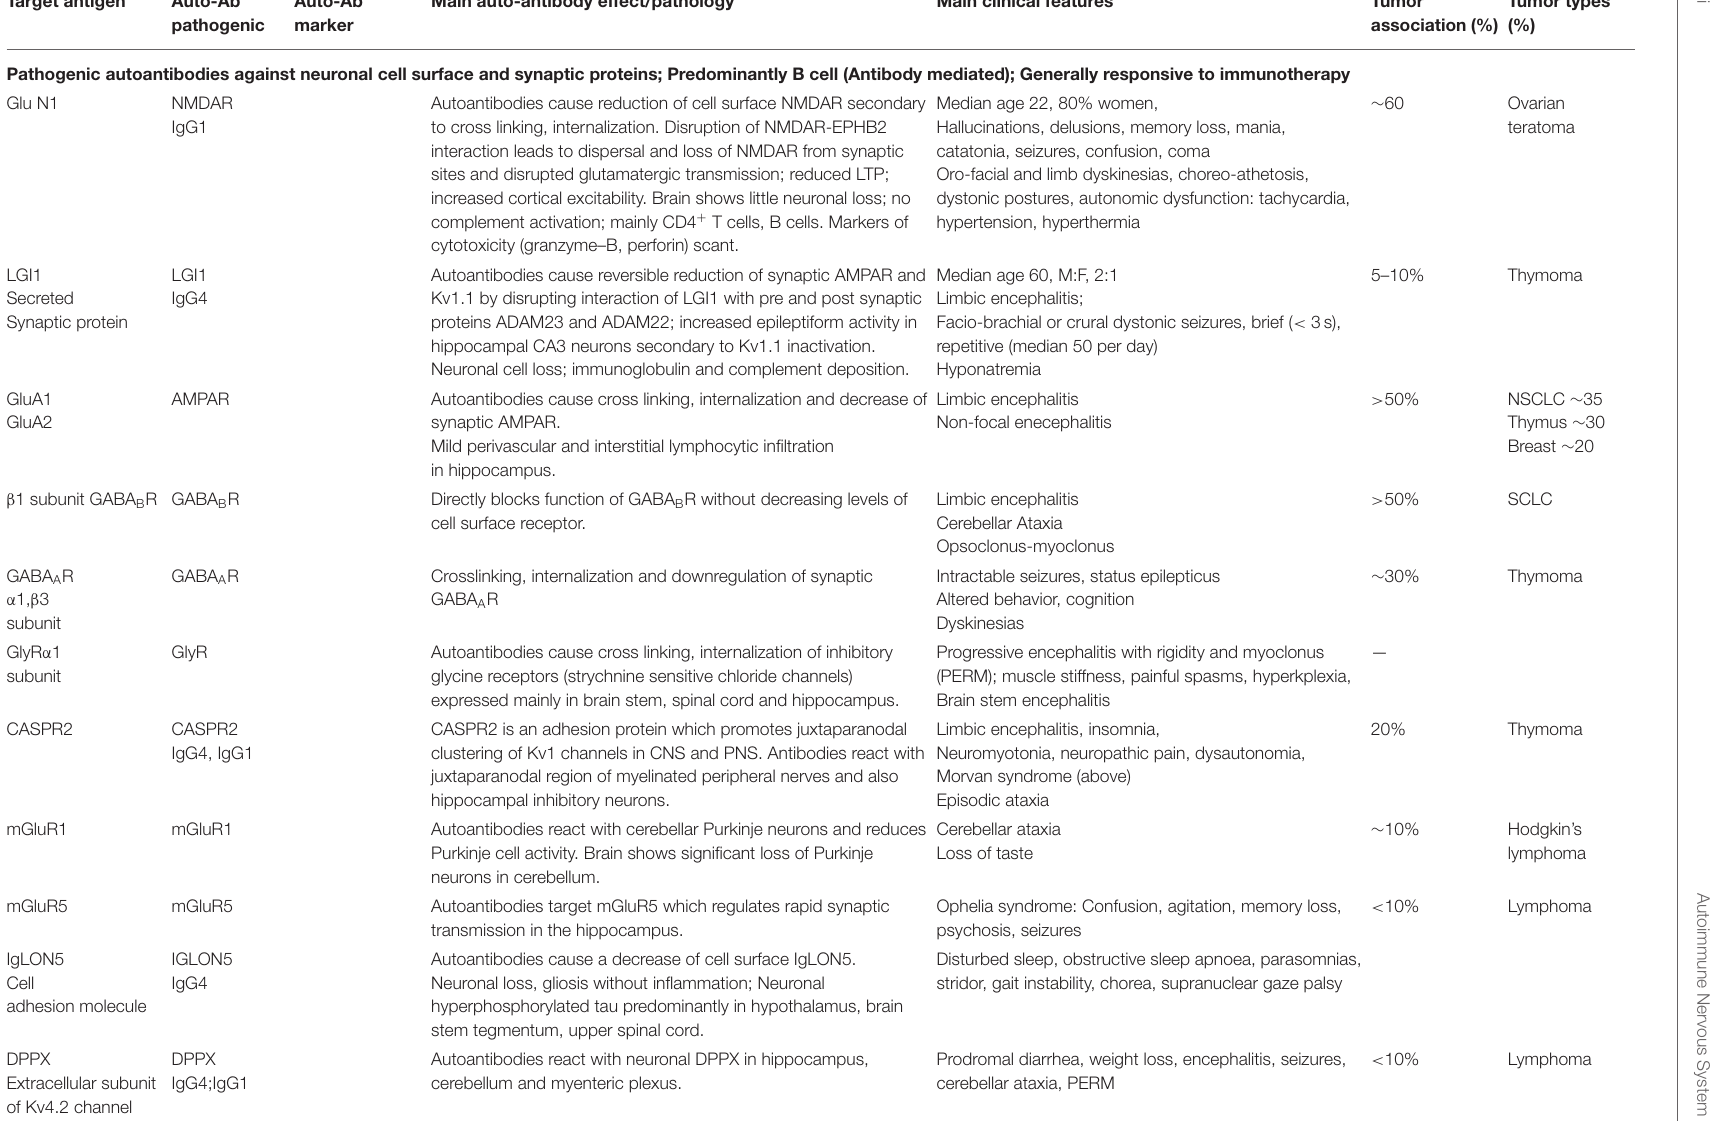
TABLE 1 | Main features of autoimmune diseases of the central nervous